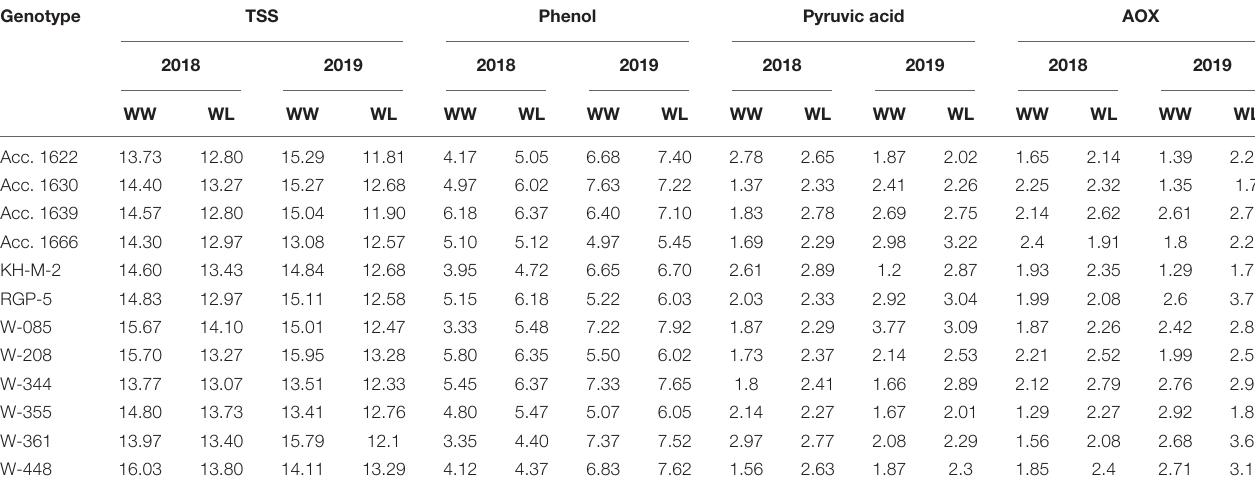
TABLE 6 | Biochemical traits of contrasting onion genotypes evaluated under well-watered and waterlogging conditions. Genotype TSS Phenol Pyruvic acid AOX